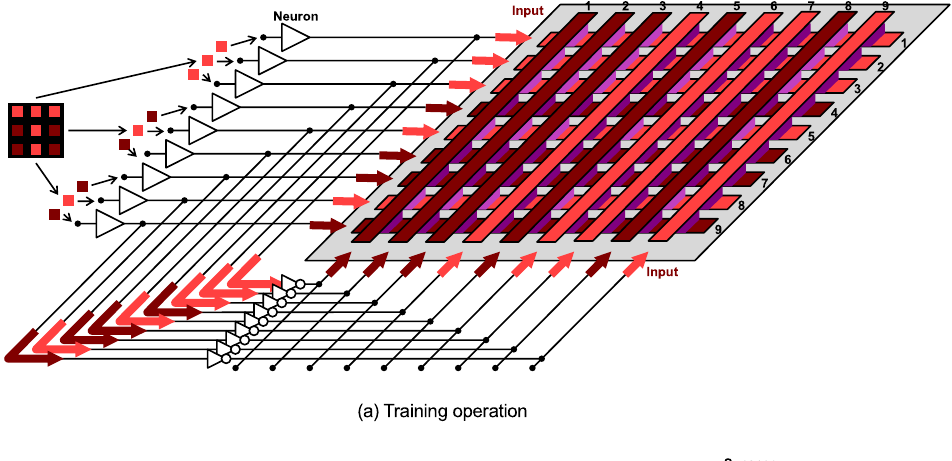
dark purple indicates that the electrical conductance is maintained. During the inference operation, the volt- age that corresponds to the pattern slightly distorted from the memorized pattern is applied only to the bottom electrodes. Also in Fig. 5b, the bright purple indicates that the electrical conductance increases, whereas the dark purple indicates that the electrical conductance is maintained. Consequently, some voltage is finally output after the transient behavior, which is a revised pattern. Notably, because the GTO memristor autonomously modi- fies its own electrical characteristic, extra control circuits are not necessary, which means that the training and inference operation can be regarded as autonomous local learning. It should be noted that the revised pattern is